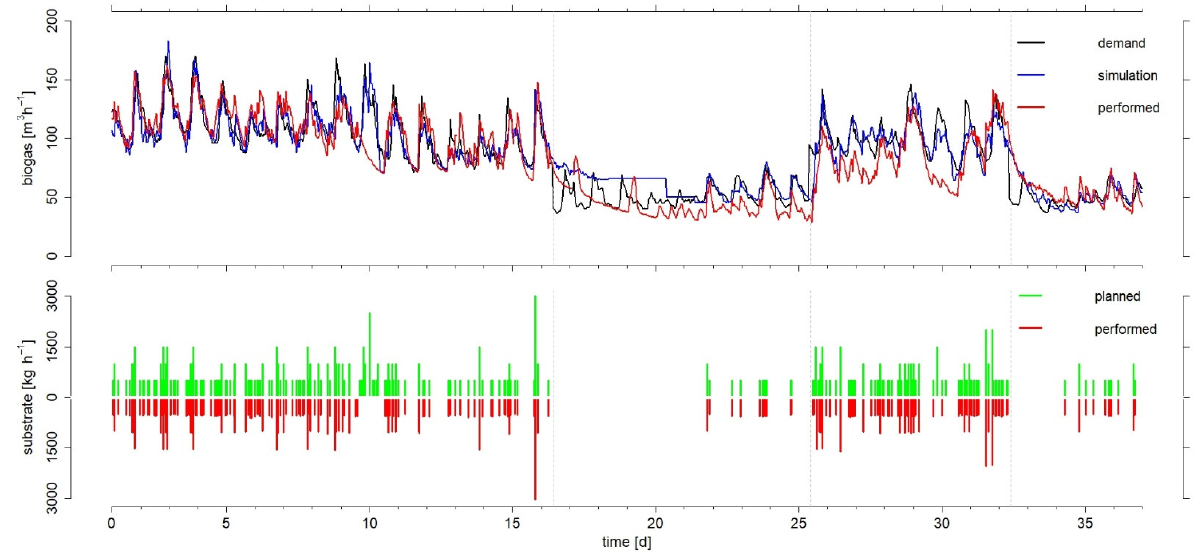
Figure 4. Biogas demand, simulated biogas production and biogas produced, as well as the associated daily feeding schedules and the feedings performed in hourly resolution over the entire experimental period. Table 2. Mean values of accuracy parameters SMAPE [%], MAPE [%] and MAE [m 3 ] as well as the difference between biogas demand and production (diff. [m 3 ]) for evaluating the quality of simulation (comparison data of the simulation and the biogas produced) [Sim] and of the final results of the whole feeding management model (comparison data biogas demand and the biogas produced)